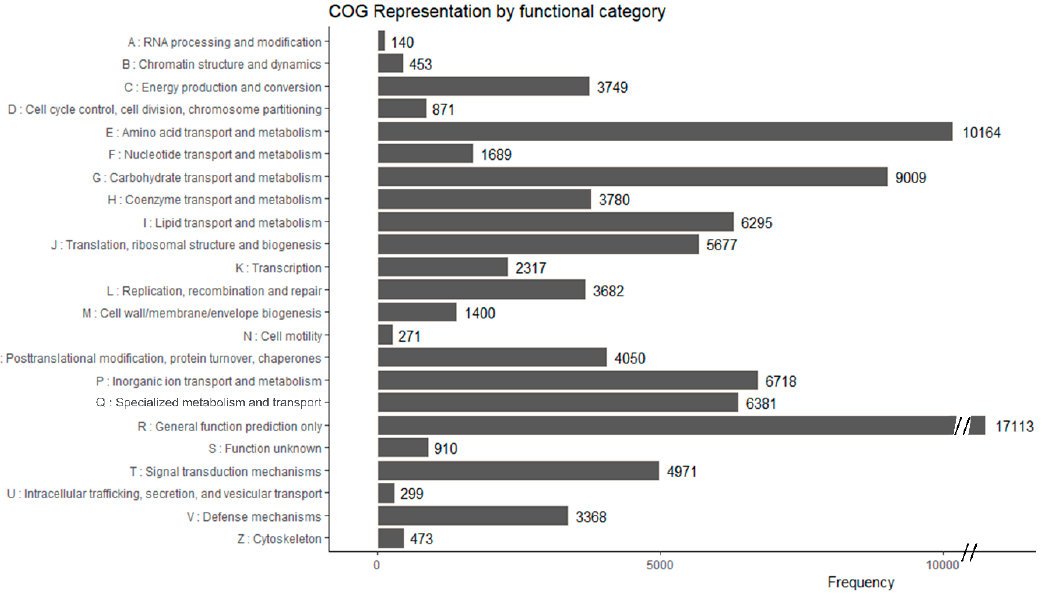
Figure 3. Functional classification of Armillaria sinapina transcriptome using the Cluster of orthologous groups (CoG).